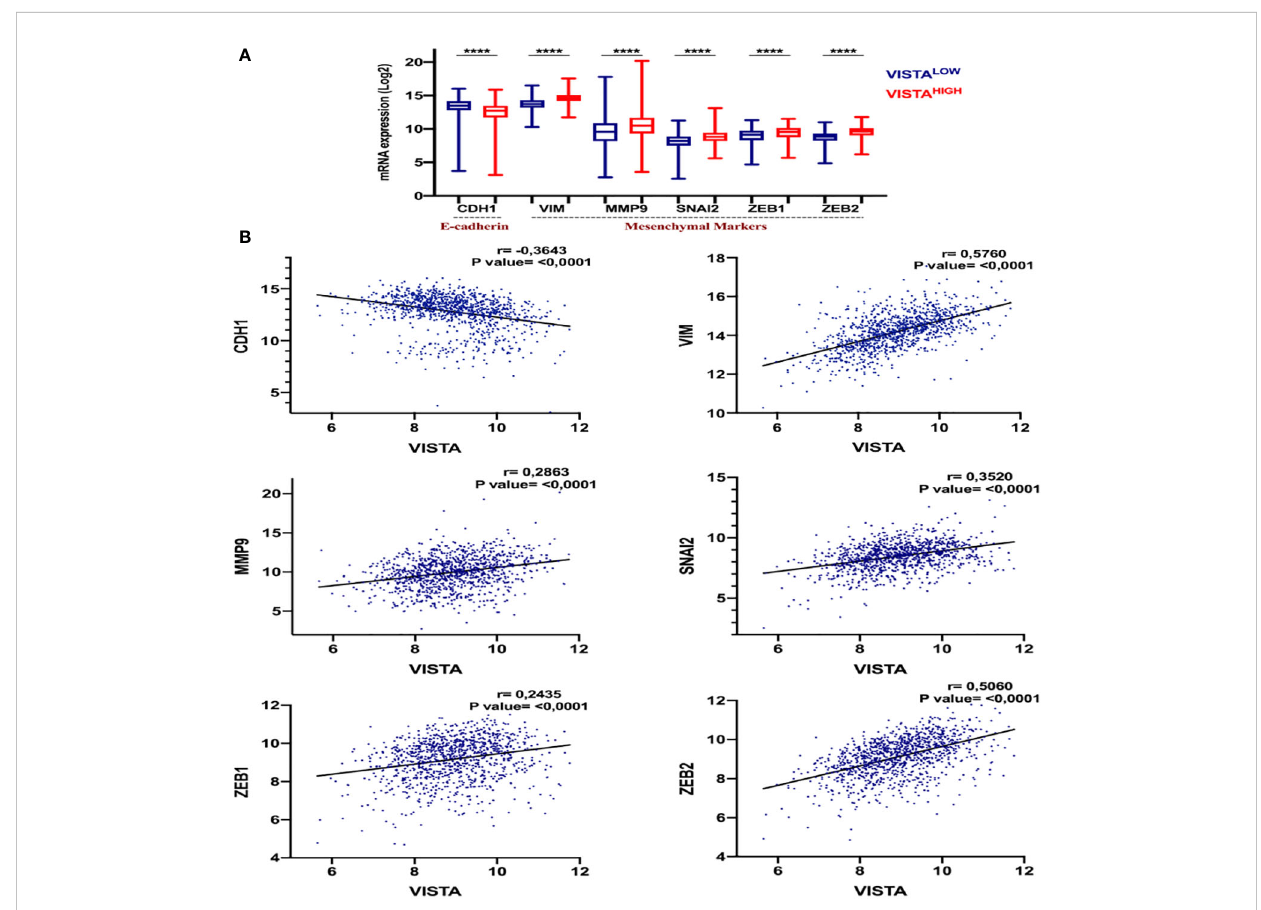
FIGURE 5 The potential association of VISTA expression and the Epithelial-mesenchymal transition (EMT) in breast cancer patients. (A) The expression levels of EMT genes in High versus Low VISTA groups in the TCGA cohort. The p-value is 0.05. (B) The correlation of VISTA expression with the EMT markers. ****Indicates p-value <